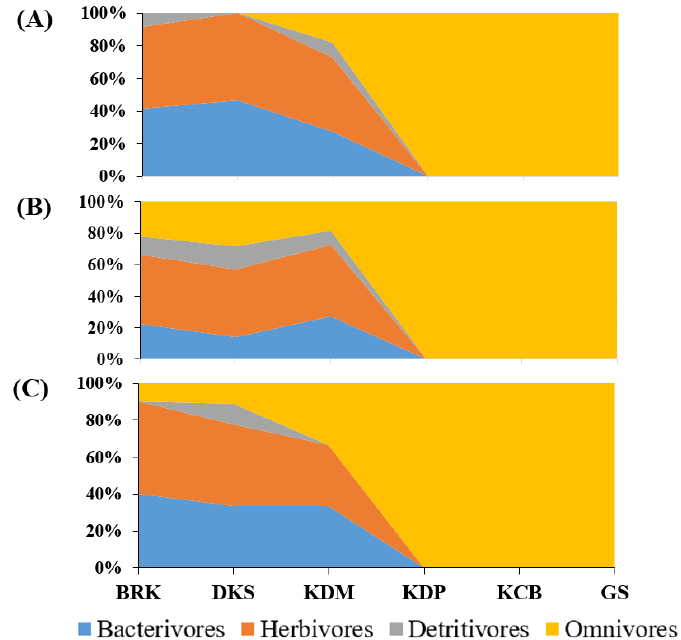
Figure 7. Percent (%) composition of zooplankton trophic guild at six sampling stations during October 2017 ( A ), February 2018 ( B ), and June 2018 ( C ) in the HRE.